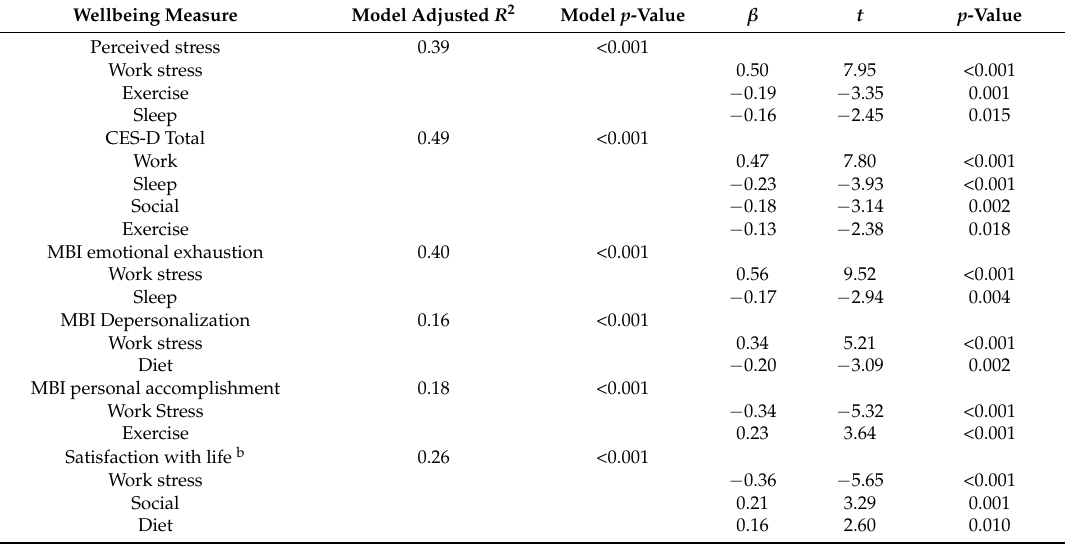
Table 5. Lifestyle behavior predictors, R 2 and betas on measures of wellbeing a